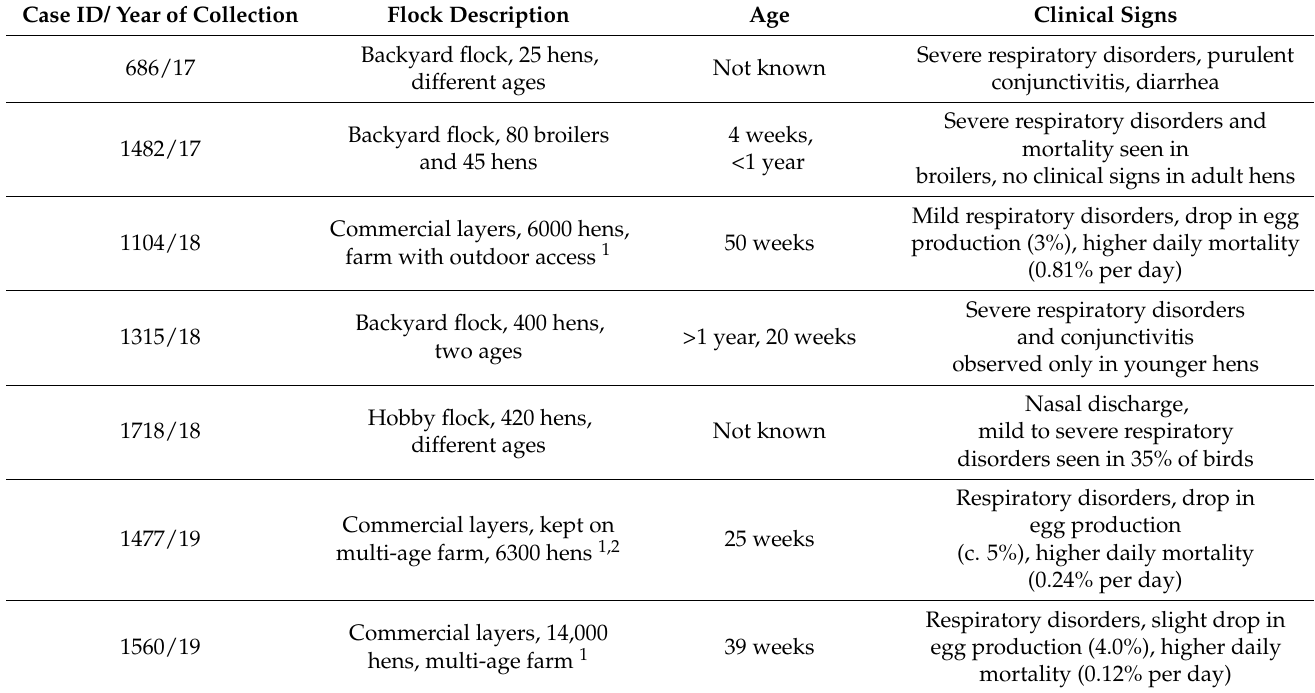
Table 1. Description of poultry flocks with suspicion of ILT